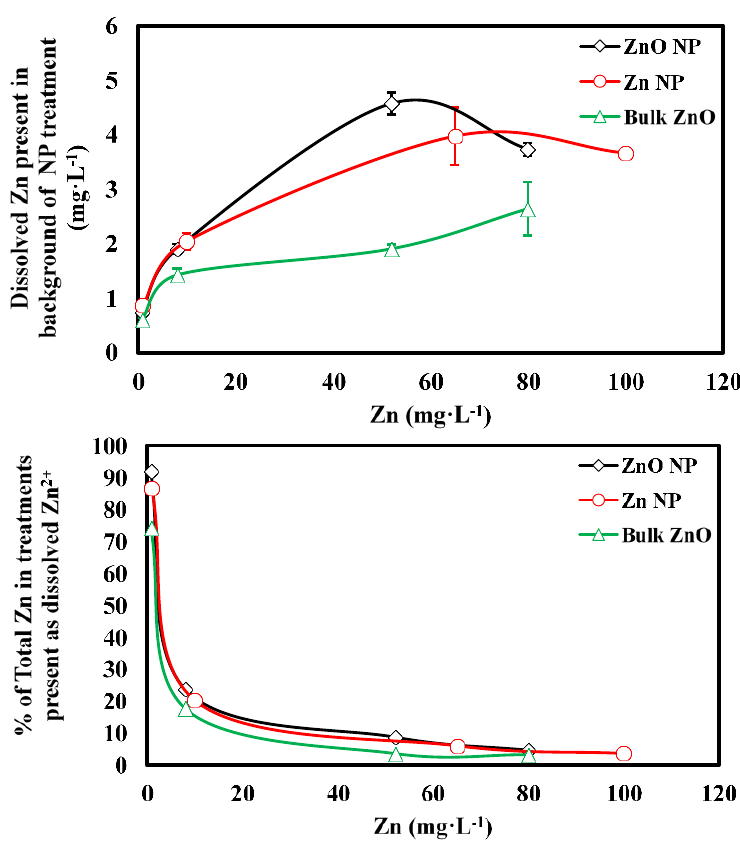
Figure 2. Dissolved Zn measured in the background of treatment suspensions ( top ) and the percentage of total Zn that is present at dissolved Zn ( bottom ).